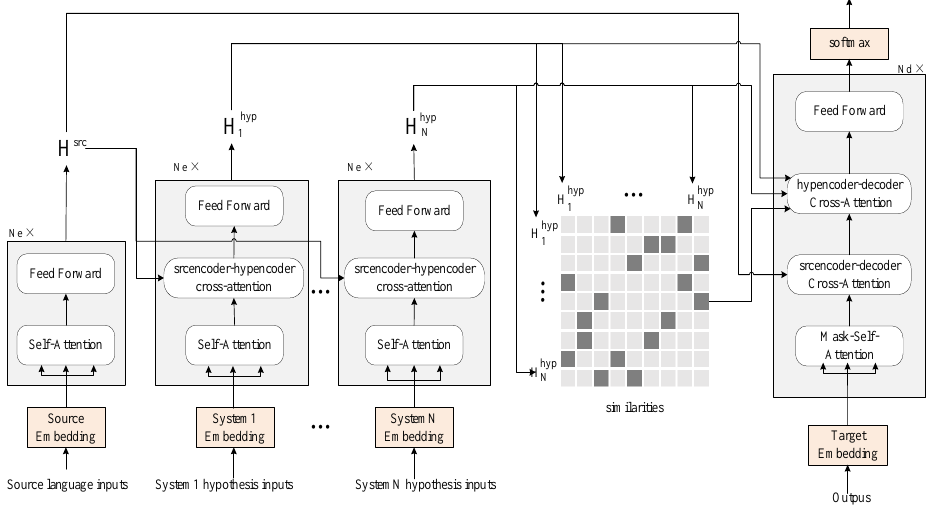
Figure 3. The architecture of the multi-source combination model based on the voting mechanism. The similarities between hypotheses are the core of the model.